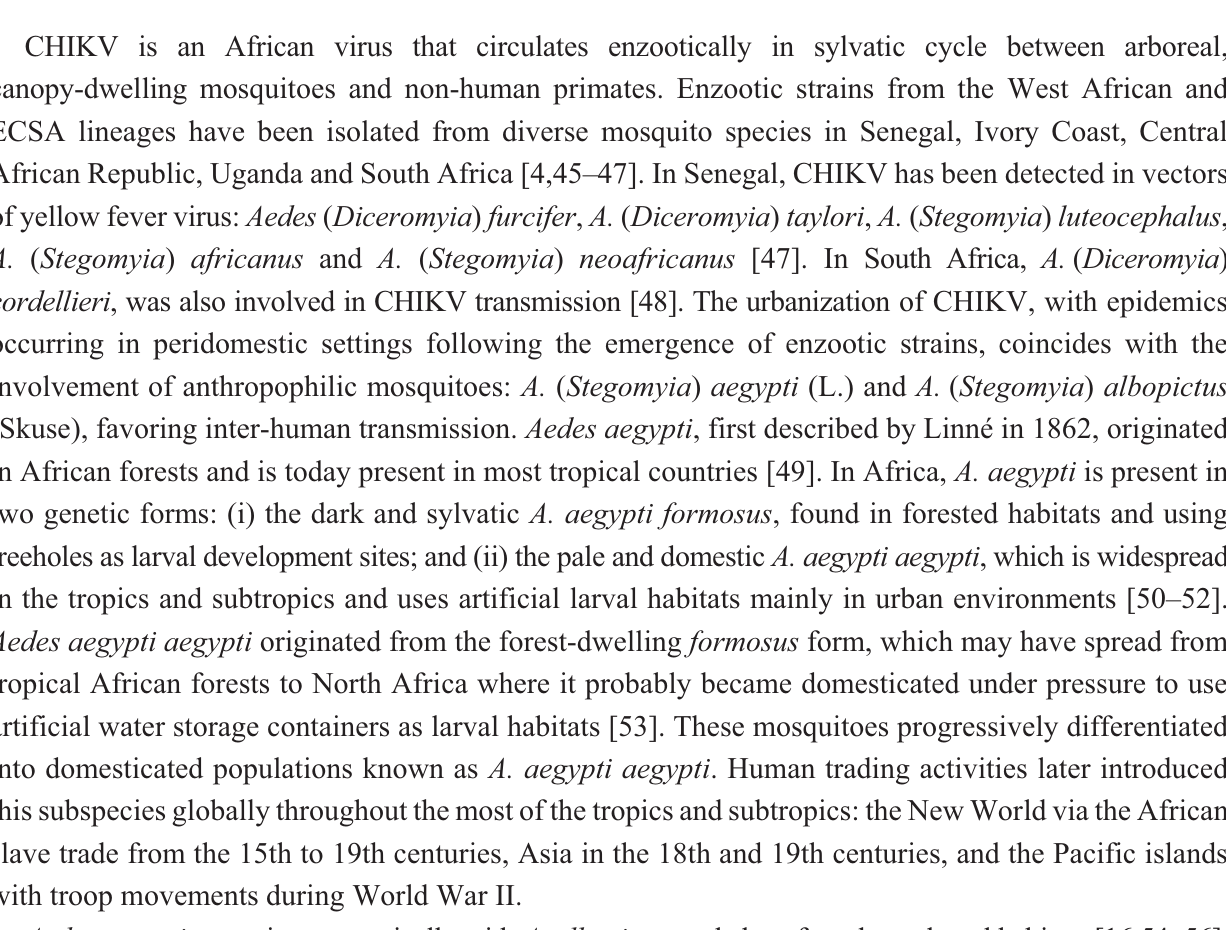
Figure 1. Geographic distribution and spread of Chikungunya virus (CHIKV) and its two urban vectors, A. aegypti and A. albopictus . Modified from reference [42], with permission. American populations of A. aegypti and A. albopictus are susceptible to both ECSA/IOL and Asian genotypes of CHIKV with higher susceptibility observed for A. aegypti and the Asian CHIKV genotype, or A. albopictus and the ECSA/IOL genotype [43]. As of November 2014, 11 locally acquired cases